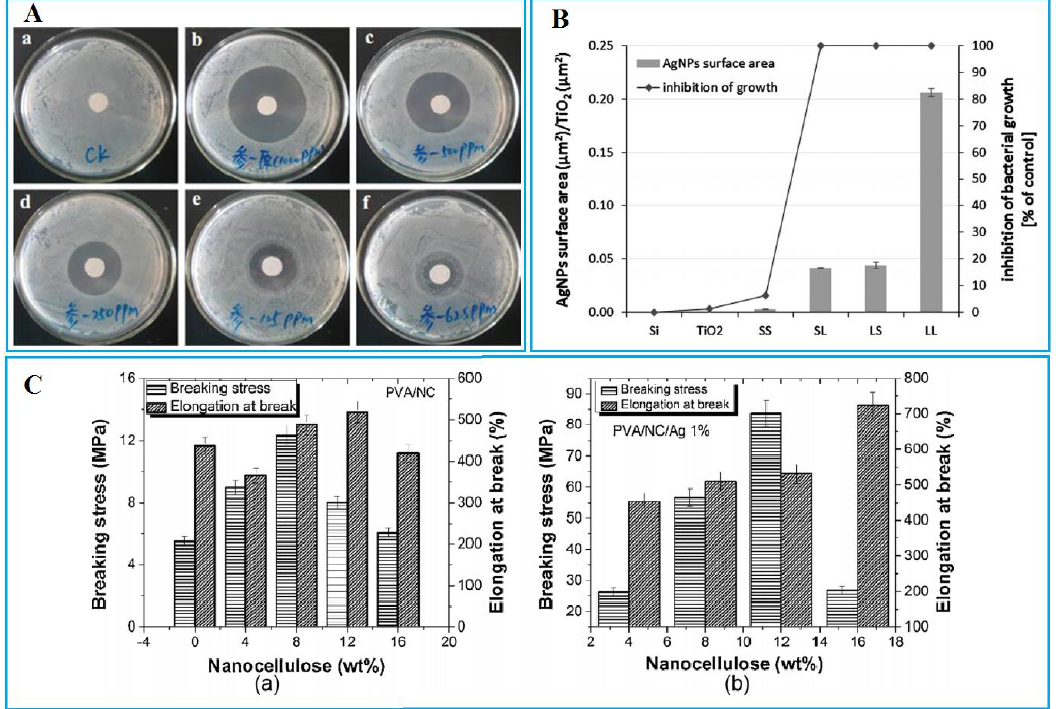
Figure 1. ( A ) Disk diffusion test of AgNPs against E. coli (a: Control; b: 1000 ppm; c: 500 ppm; d: 250 ppm; e: 125 ppm; f: 62.5 ppm). Reprinted with permission from [49]. Copyright 2020 Ingenta. ( B ) The surface area of AgNPs showed an association with growth inhibition of S. aureus after 24 h of incubation on TiO 2 coatings with AgNP. Reprinted with permission from [50]. Copyright 2014 The Royal Society of Chemistry. ( C ) Elongation and breaking stress at the break of (i: neat PVA, PVA/NC) and (ii: PVA/NC 4%/Ag 1%). Reprinted with permission from [44]. Copyright 2018